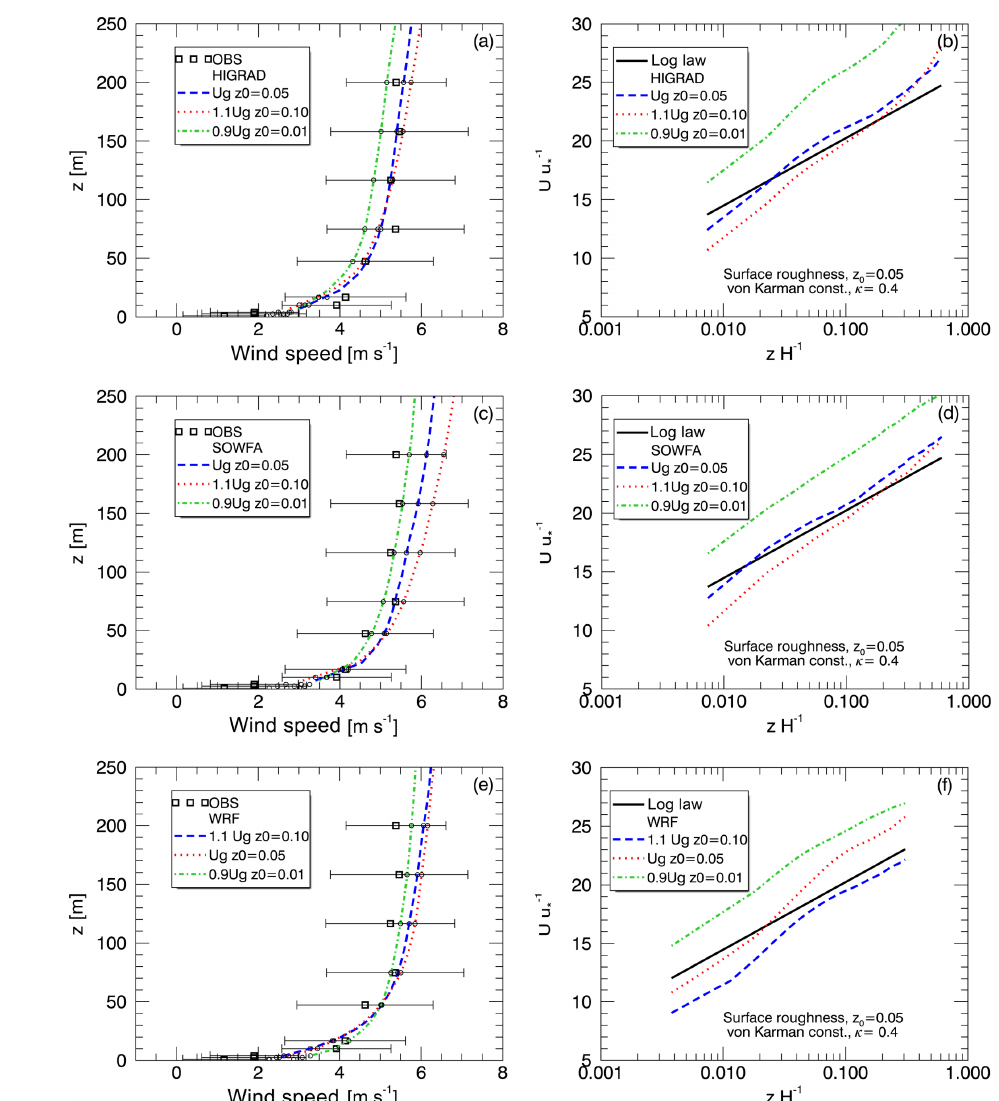
Figure 9. Impacts of varying surface roughness length and geostrophic wind speed using HiGrad (a, b) , SOWFA (c, d) , and WRF (e, f) , on simulated profiles of time-averaged wind speed, plotted against observations (a, c, e) and the theoretical logarithmic profile shape (b, d, f) , from the neutral case